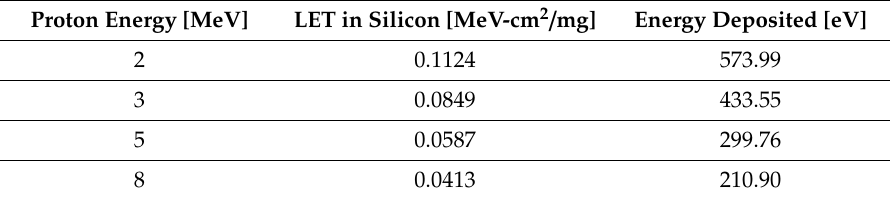
Table 3. Energy deposited in the sensitive volume calculated with LET method.